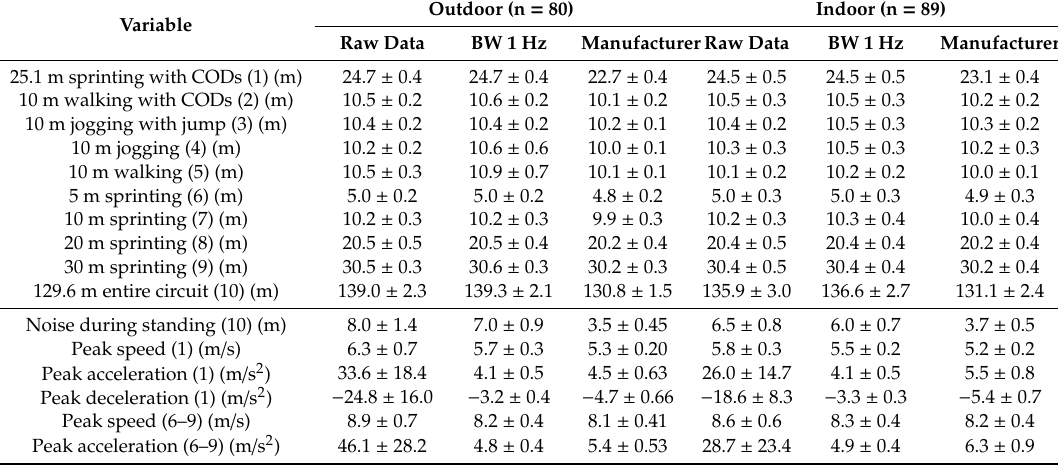
Table 2. Descriptive data (mean ± SD) of the local positioning system for determining the distances covered during outdoor and indoor conditions. The impacts of the di ff erent filtering techniques, and the outcomes of the raw data, are also